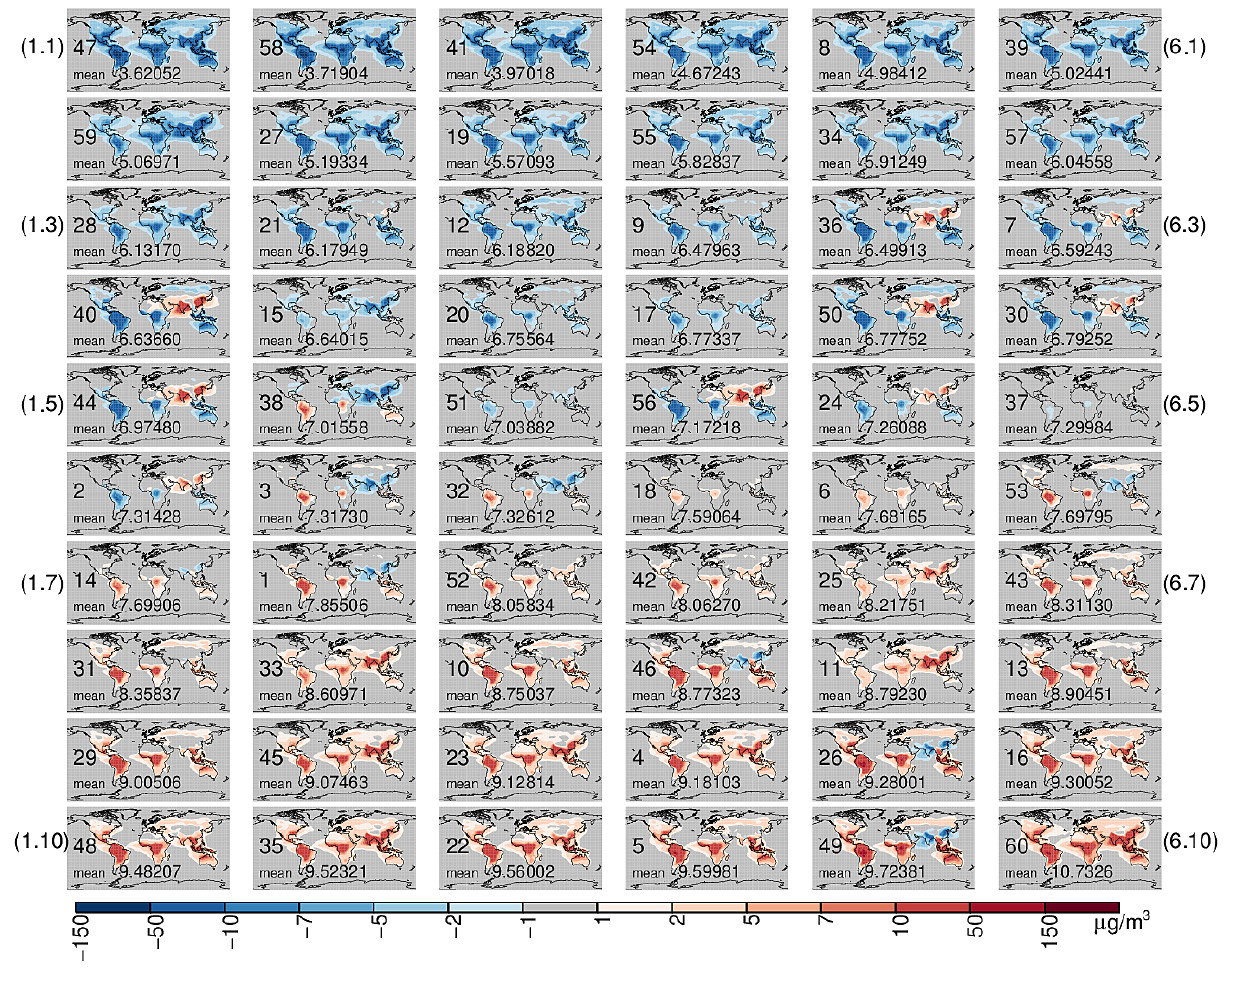
Figure 4. Global annual mean anomaly of organic aerosol mass at the surface (OA in microgrammes per cubic metre) produced within the ensemble. Each subplot shows the anomaly of an ensemble member (numbered between 1 and 60) from the ensemble mean OA. The global mean OA is given on each subplot. The subplots are arranged in order of increasing global mean